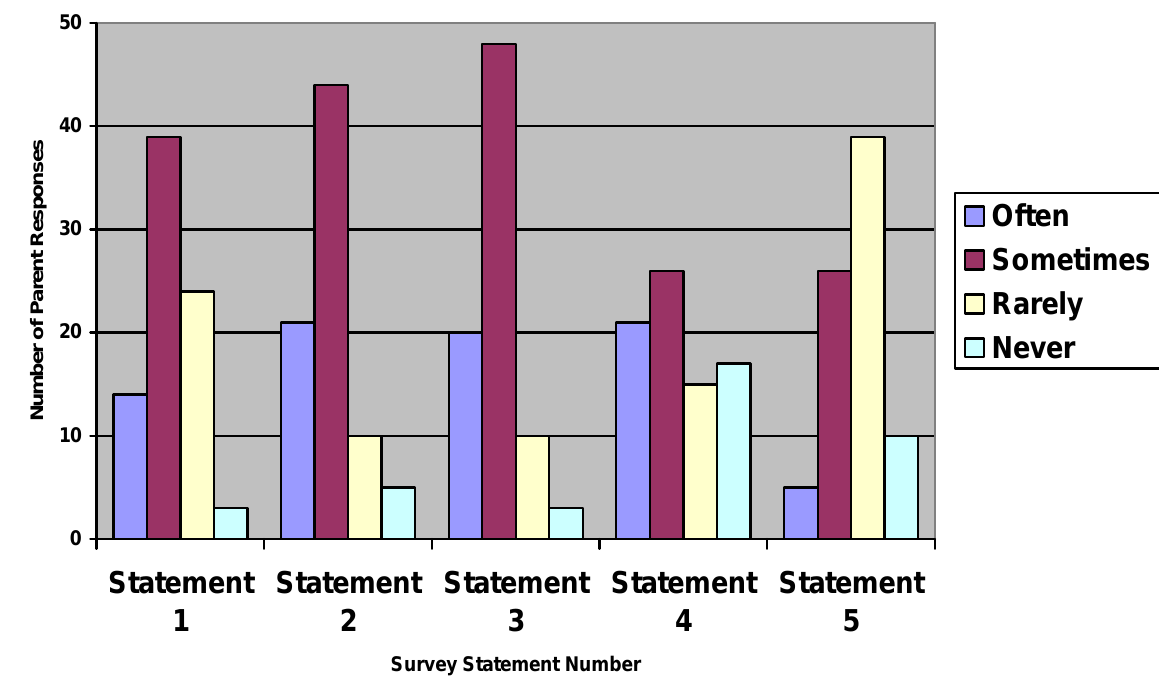
Figure 3. Parent Survey from week one prior to implementation of posting and communicating daily learning